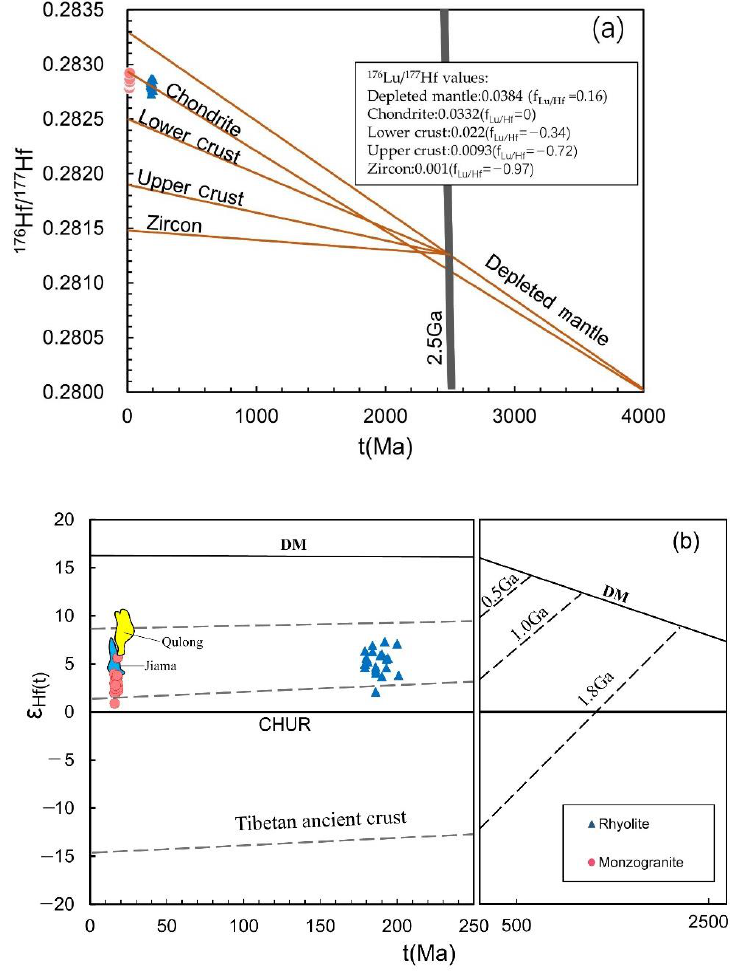
Figure 11. Zircon ε Hf (t) data plotted against zircon U–Pb ages. Data sources: Qulong from [61]; Jiama from [62]. DM—depleted mantle; CHUR—chondritic uniform reservoir. ( a ) ( 176 Hf/ 177 Hf)/t(Ma); ( b ) ε Hf (t)/t(Ma)